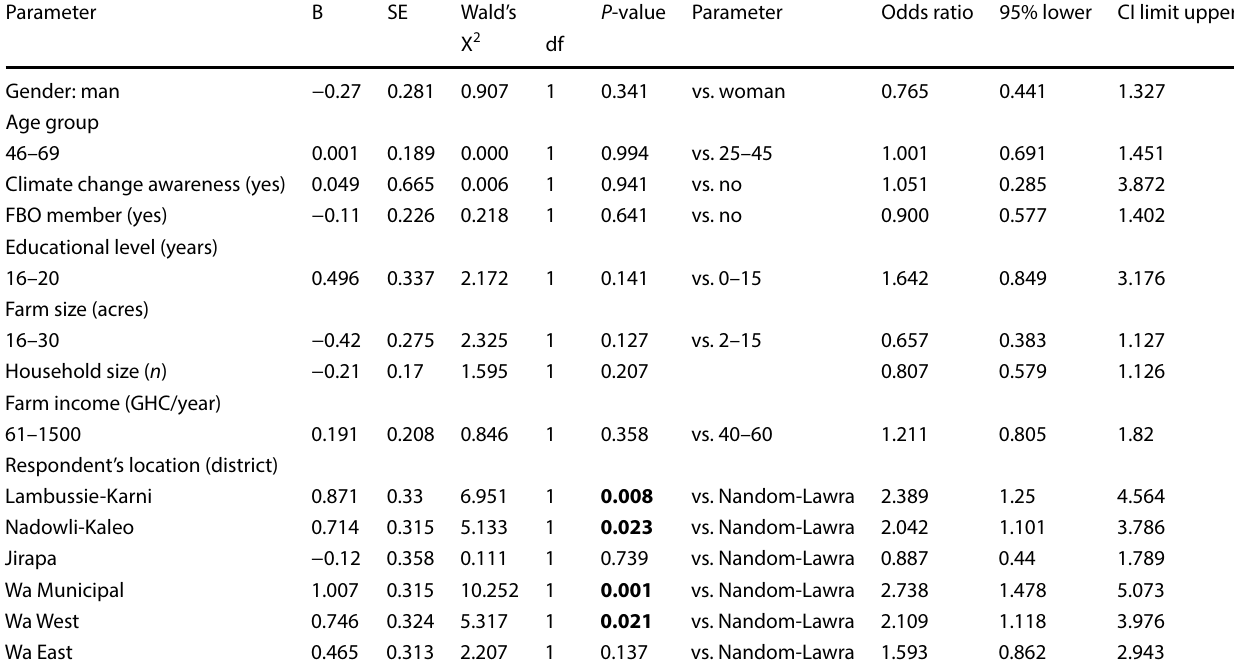
Table 9 Logistic regression estimates (maximum likelihood and odds ratios) for socio-economic data-predicting adaption of early maturing crops (1) versus none (0)